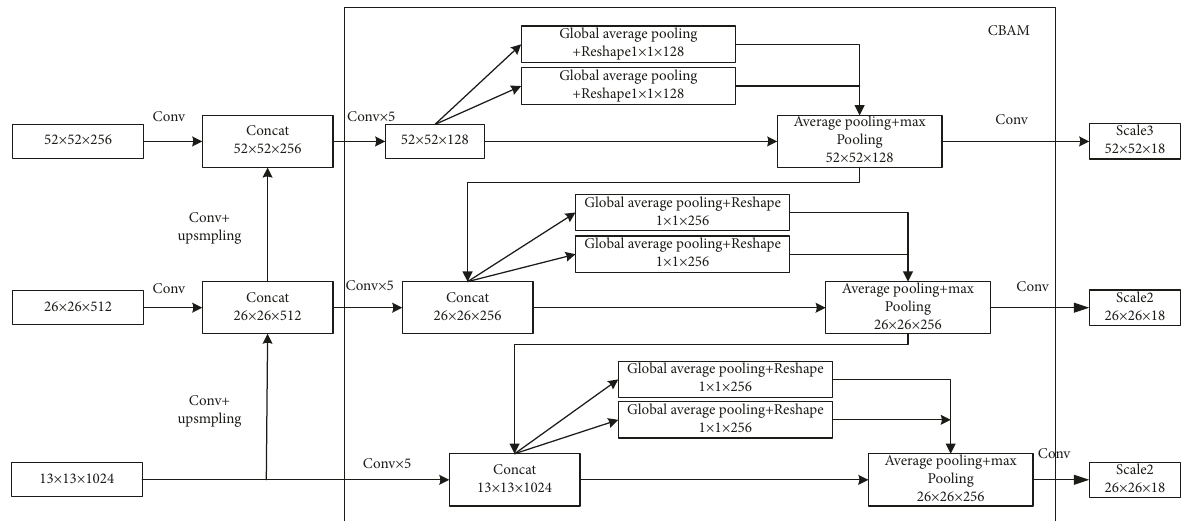
Figure 4: CBAM model structure with dual attention